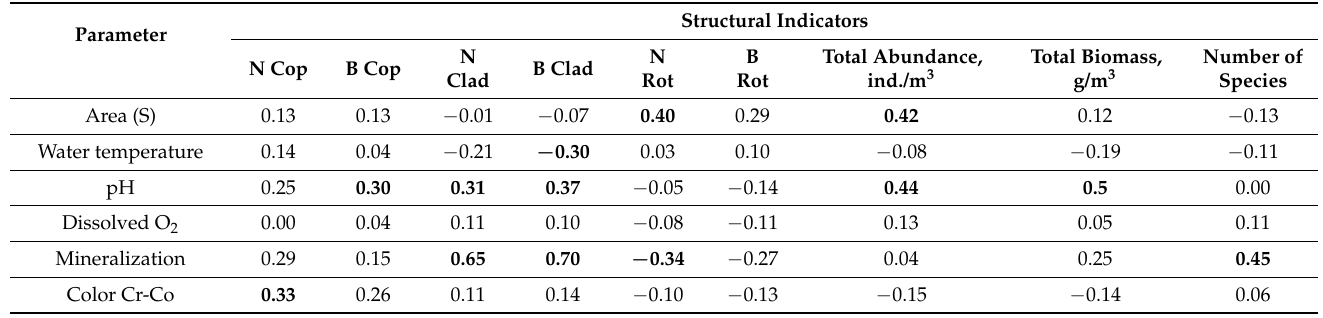
Table 3. Correlation analysis of zooplankton structural indicators with hydrological and hydro- chemical factors.